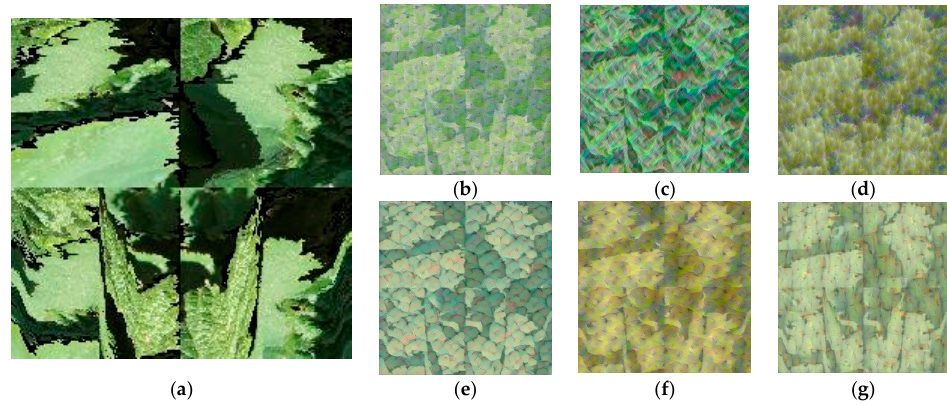
Figure 12. The six features learned by the last fully connected layer (fc8) of the proposed network